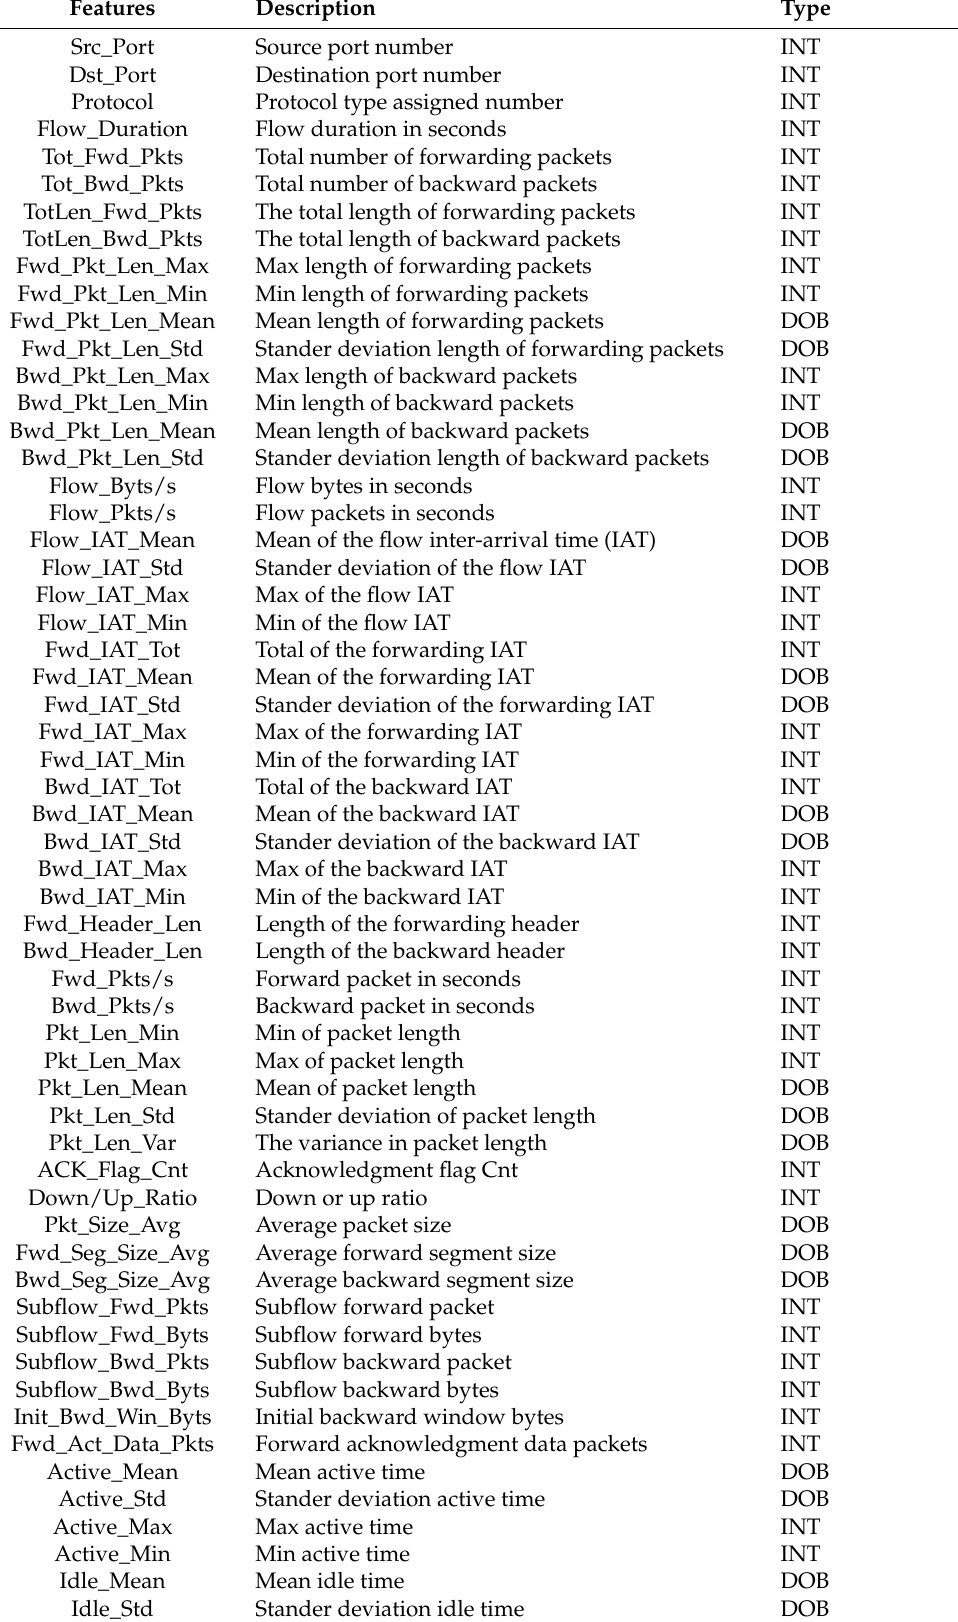
Table 3. Dataset feature